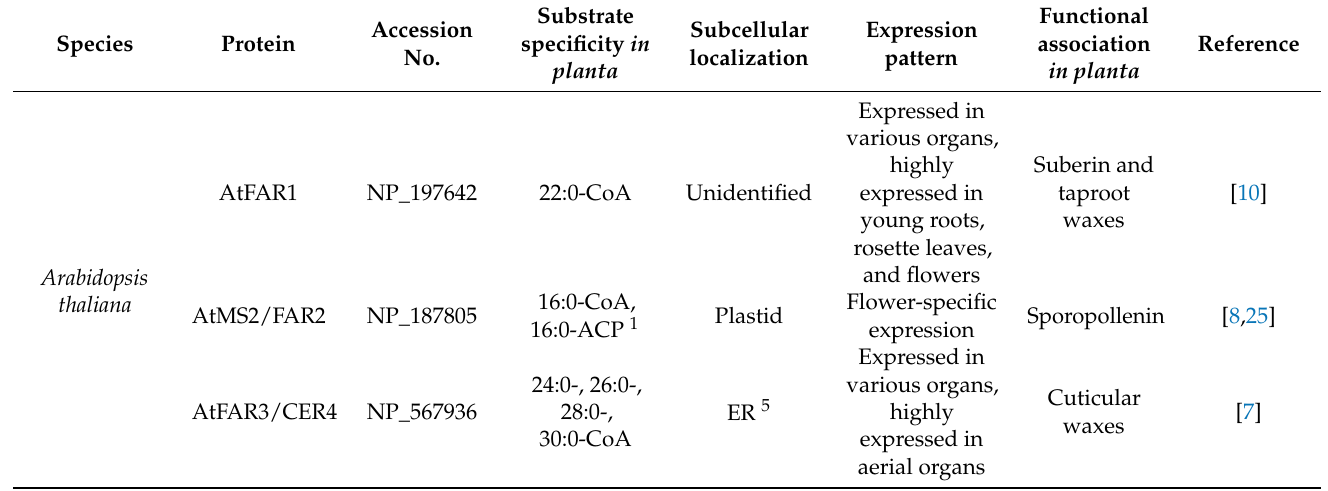
Table 1. Substrate specificity, subcellular localization, expression pattern and function of